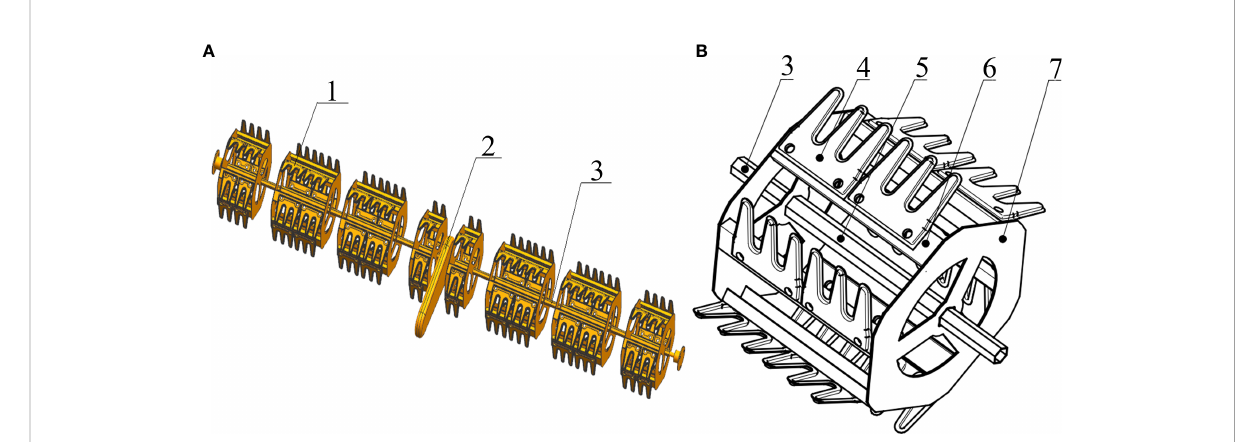
FIGURE 2 Schematic diagram of (A) inter-row weeding component and (B) individual weeding wheel (1. Weeding wheel. 2. Gear box. 3. Square shaft. 4. Rake tooth. 5. Bearing sleeve. 6. Mounting base. 7. Side